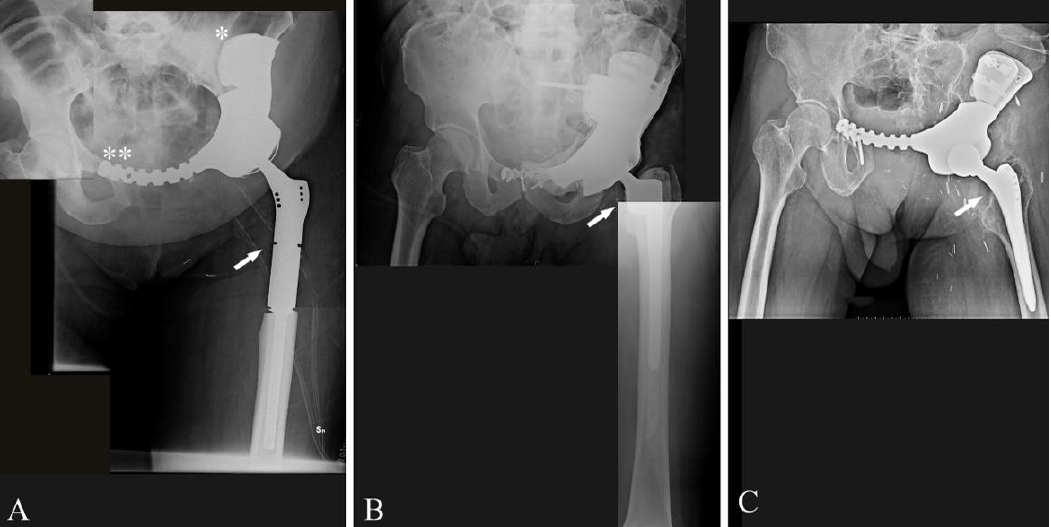
Figure 4. ( A ) Post-operative X-ray showing reconstruction after G1 chondrosarcoma of the left hemipelvis with a 3DPTCMP fixed to the residual iliac bone with a “wafer” system (white asterisk) and then to the residual symphysis with a plate (double white asterisk); proximal femur was reconstructed with a modular prosthesis and a constrained cup (white arrow) (case 1); ( B ) post-operative X-ray showing reconstruction after resection of a left hemipelvis G2 chondrosarcoma; reconstruction was performed with a short modular femoral prosthesis (white arrow) and a constrained cup cemented in a 3DPTCMP (case 5); ( C ) post-operative X-ray showing reconstruction after resection of a left hemipelvis G3-Chondrosarcoma; reconstruction was performed with a standard femoral stem prosthesis (white arrow) and a constrained cup cemented in a 3DPTCMP (case 12).